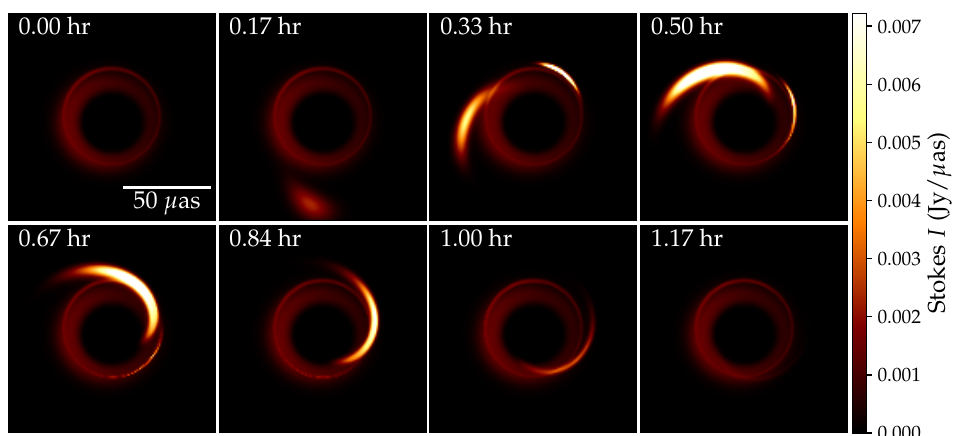
Figure 4. Frames of a hotspot simulation using the model from Tiede et al. [74], where a shearing hotspot is superimposed on top of a static accretion flow. By tracking the motion of the hotspot, the ngEHT could constrain the dynamics of the accretion flow. Additionally, while the motion of the primary hotspot is highly dependent on the accretion flow, the appearance of the secondary image probes the black hole spacetime [71,72] allowing for a direct measurement of the black holes spin and